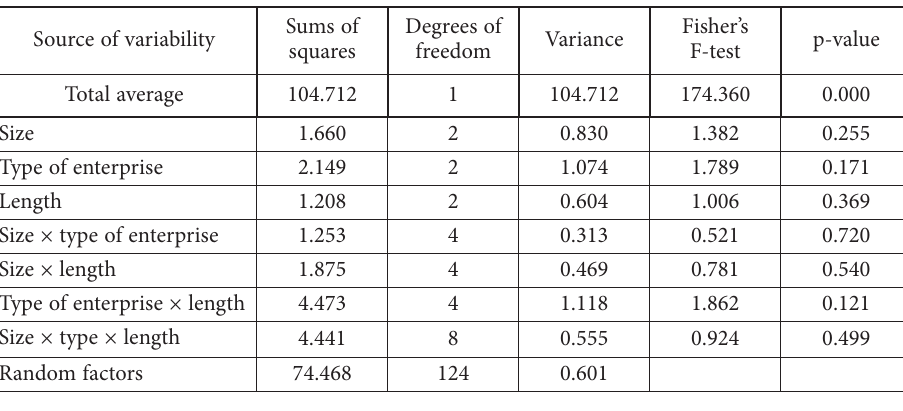
Table 4. Three-factor analysis of variance